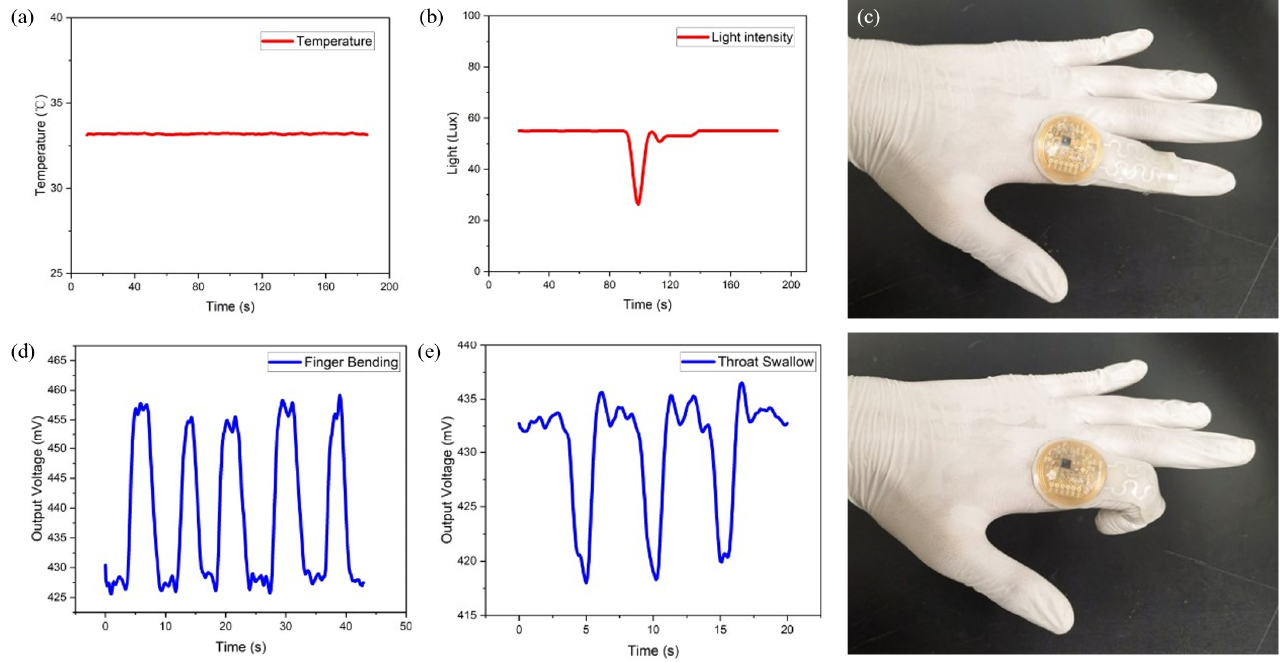
Figure 7. Epidermal signal monitoring of ( a ) temperature and ( b ) light intensity; ( c ) Illustration of real-time motion detection with wearable patch attached to the joint of index finger; Motion detection of ( d ) index finger bending and ( e ) swallowing.